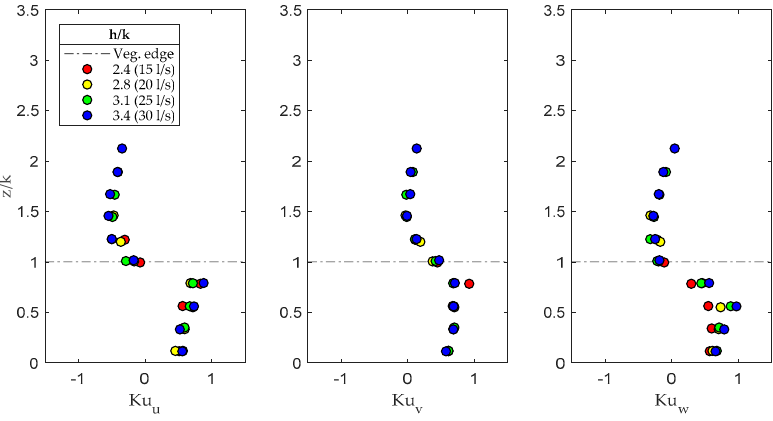
Figure 6. Kurtosis of the fluctuation velocity components in the three directions x, y, and z .